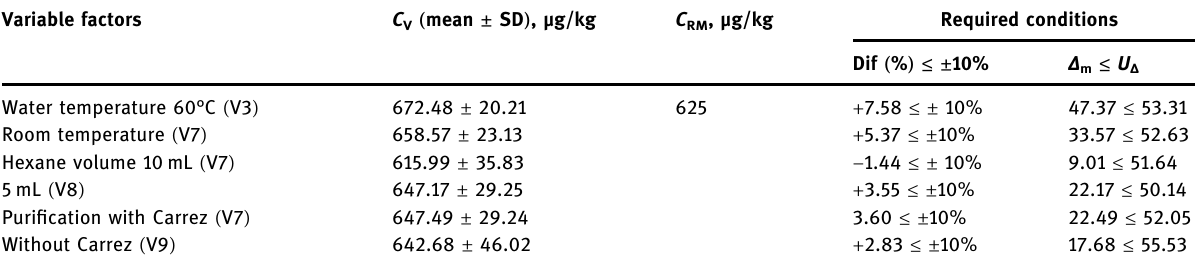
Table 3: E ff ect of di ff erent extraction factors on AA content Variable